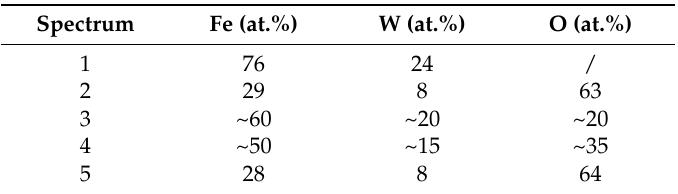
Table 1. Chemical composition as obtained by Energy Dispersive X-ray Spectroscopy (EDS) point analysis at locations shown in Figure 9. Spectrum Fe (at.%) W (at.%) O